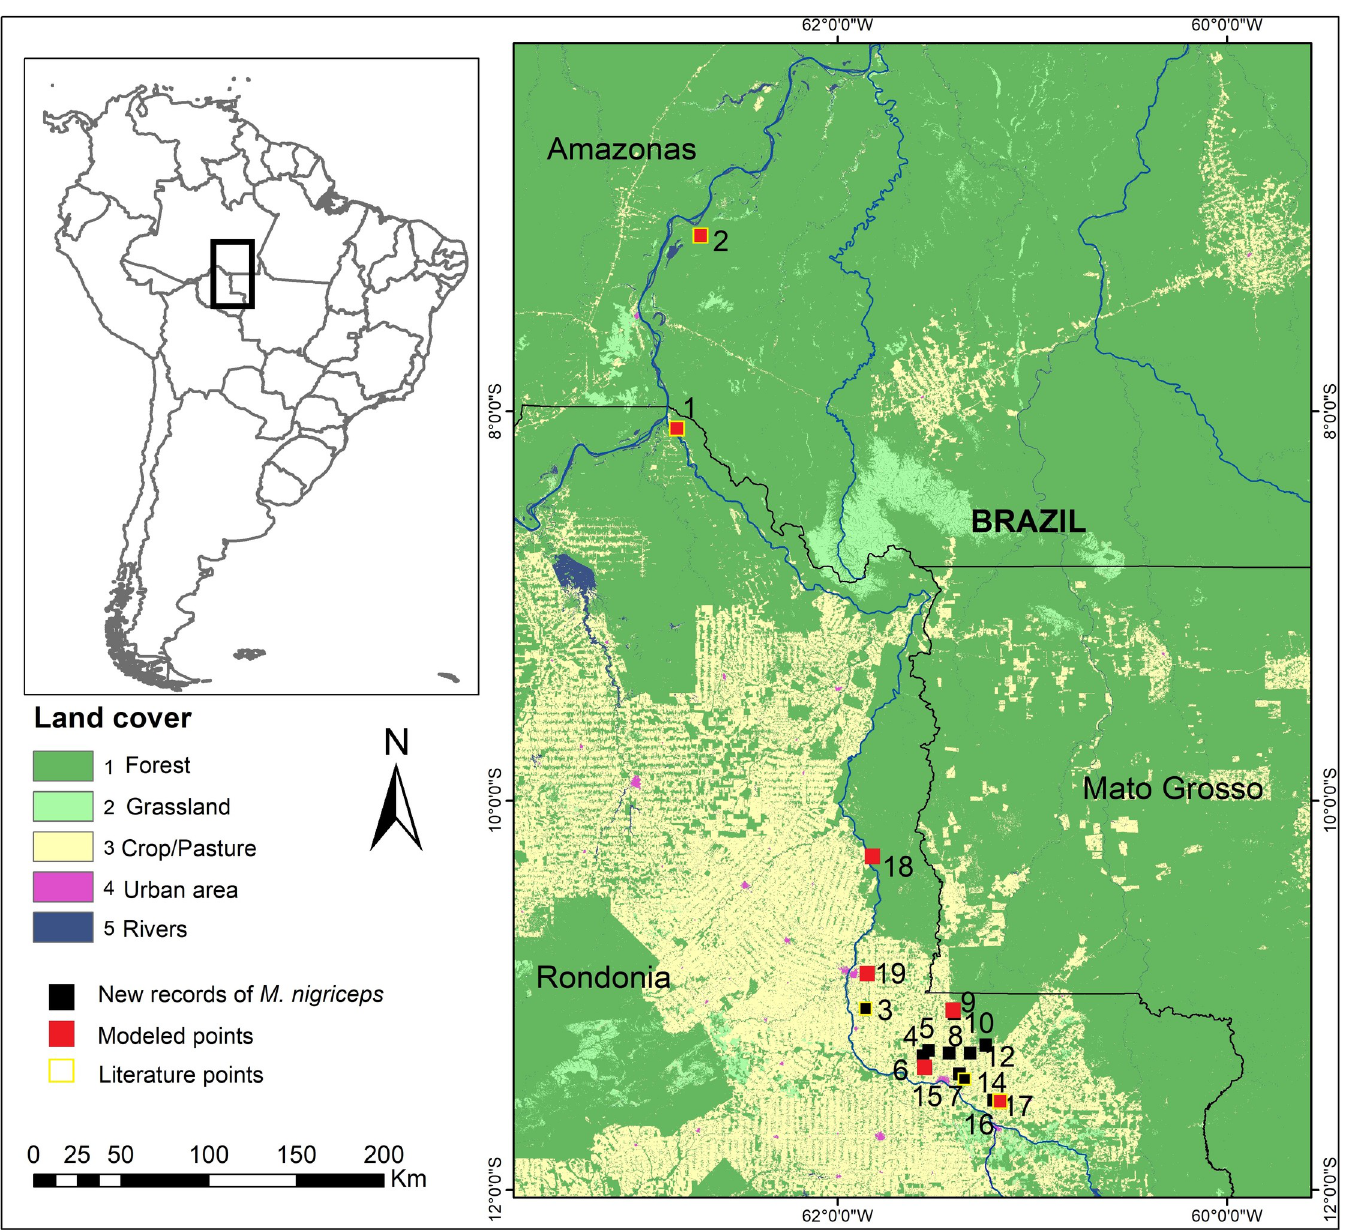
Fig 1. Study area map. Map of southwestern Brazilian Amazon showing new records of M . nigriceps , and the other known records of species of the genus Mico . The records for M . rondoni were extracted from [24, 25]; M . melanurus records are from [26, 27]; M . intermedius and M . marcai records were extracted from [28]. Reprinted from Souza et al. (10.3390/rs12172735) under a CC BY license, with permission from MapBiomas project, original copyright 2019. MapBiomas Project—Collection 5 of the Annual Series of Coverage and Land Use Maps in Brazil, accessed on 04/14/2021 through the link: https://mapbiomas.org/colecoes-mapbiomas-1?cama_set_ language=pt-BR. Shapefiles by: Ministe´rio de Meio